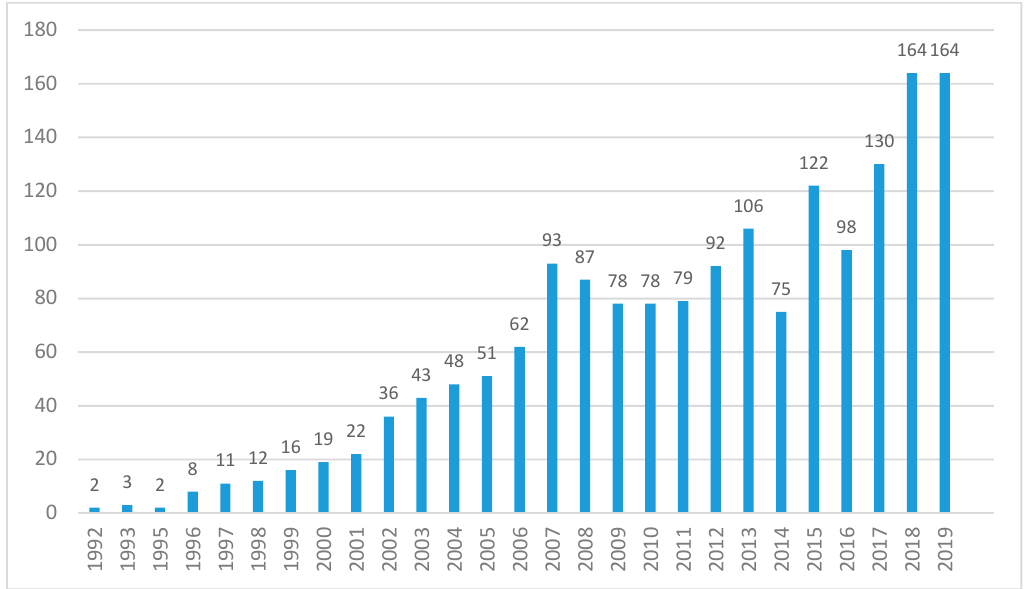
Figure 2. Dynamics of scientific investigations in domain of Mass Customization (1992–2019). Source: Composed by the authors using Web of Science Clarivate Analytics (WoS). Table 1. The 15 most cited publications in the MC domain in